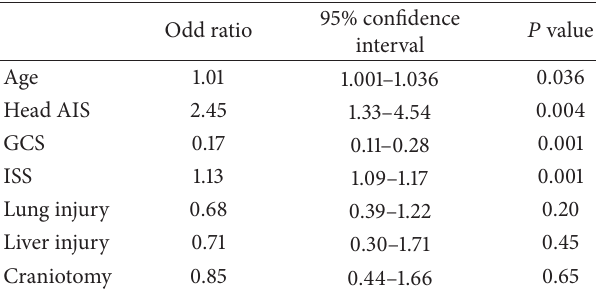
Table 5: Predictors for in-hospital mortality in traumatic head